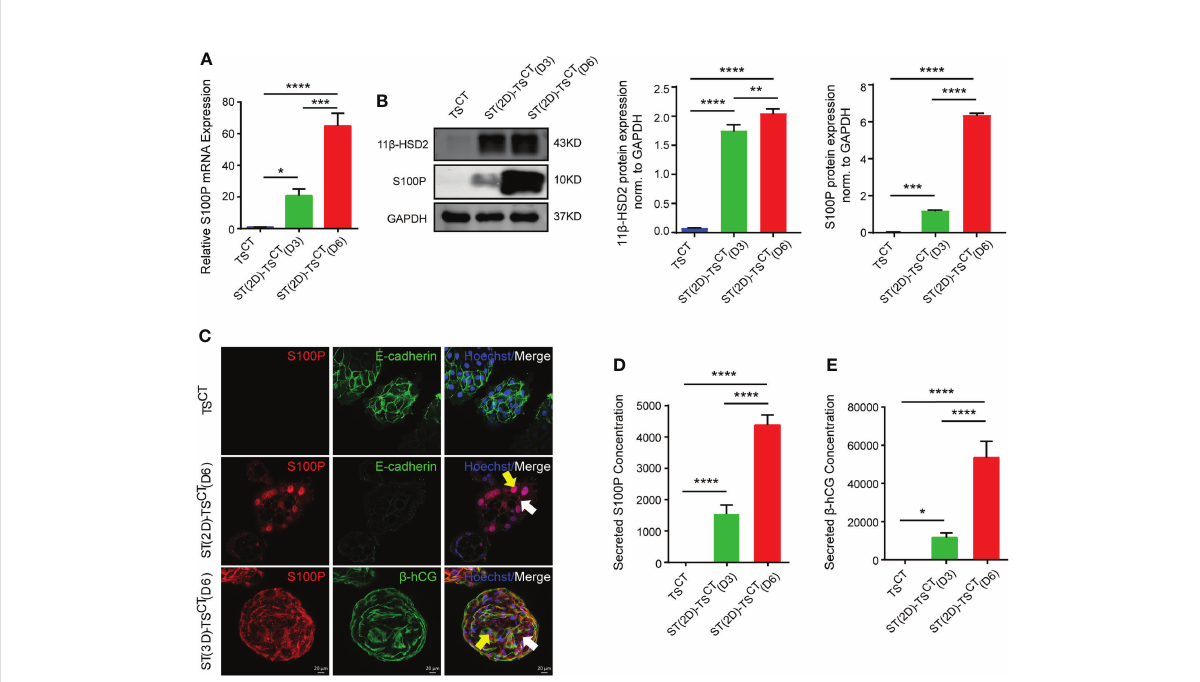
FIGURE 3 Increased S100P expression during FSK-induced syncytialization of TS CT cells. (A) Quanti fi cation of S100P mRNA expression in ST(2D)-TS CT cells measured on D3 and D6. The mean values ± SEMs (normalized to GAPDH ) are shown. D3: day 3, D6: day 6. * p =0.0110; *** p =0.0002; **** p <0.0001. (B) Western blotting analysis of S100P and 11 b -HSD2 in ST(2D)-TS CT cells measured on D3 and D6. Semiquantitative analysis of S100P and 11 b -HSD2 protein expression normalized to GAPDH (n=3). ** p =0.0073; *** p =0.0006; **** p <0.0001. (C) Immuno fl uorescence staining of S100P (red), E-cadherin (green), b -hCG (green) and Hoechst staining (blue) in human TS CT , ST(2D)-TS CT (D6) and ST(3D)-TS CT cells (D6). White arrows indicate cytoplasmic S100P expression, and yellow arrows represent nuclear S100P expression. Representative images from three independent experiments are shown. Scale bar, 20 m m. (D) Measurement of the secreted S100P levels in human TS CT and ST(2D)-TS CT cultures (D3 and D6) by ELISA. The levels were measured in three independent experiments. **** p <0.0001. (E) Measurement of secreted b -hCG levels in human TS CT and ST(2D)-TS CT cultures (D3 and D6) as assessed by ELISA. The levels were measured in three independent experiments. * p =0.0283; **** p